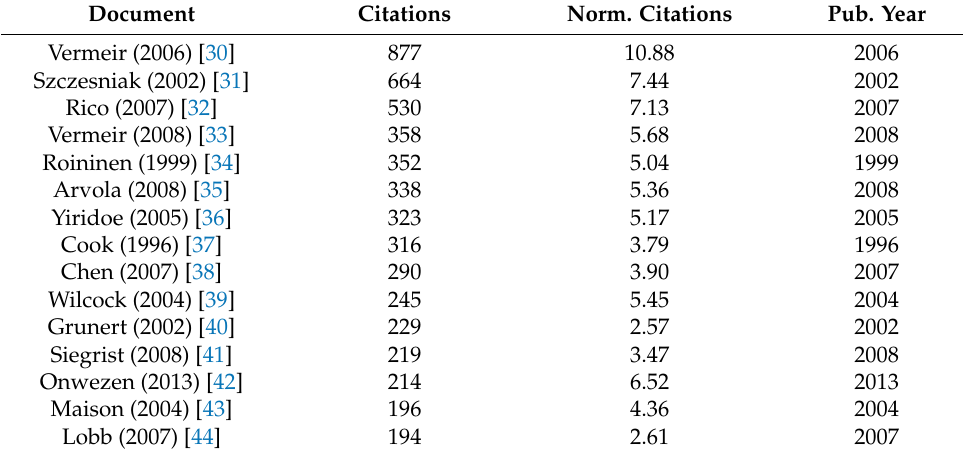
Table 2. Bibliometric information for most cited documents (top